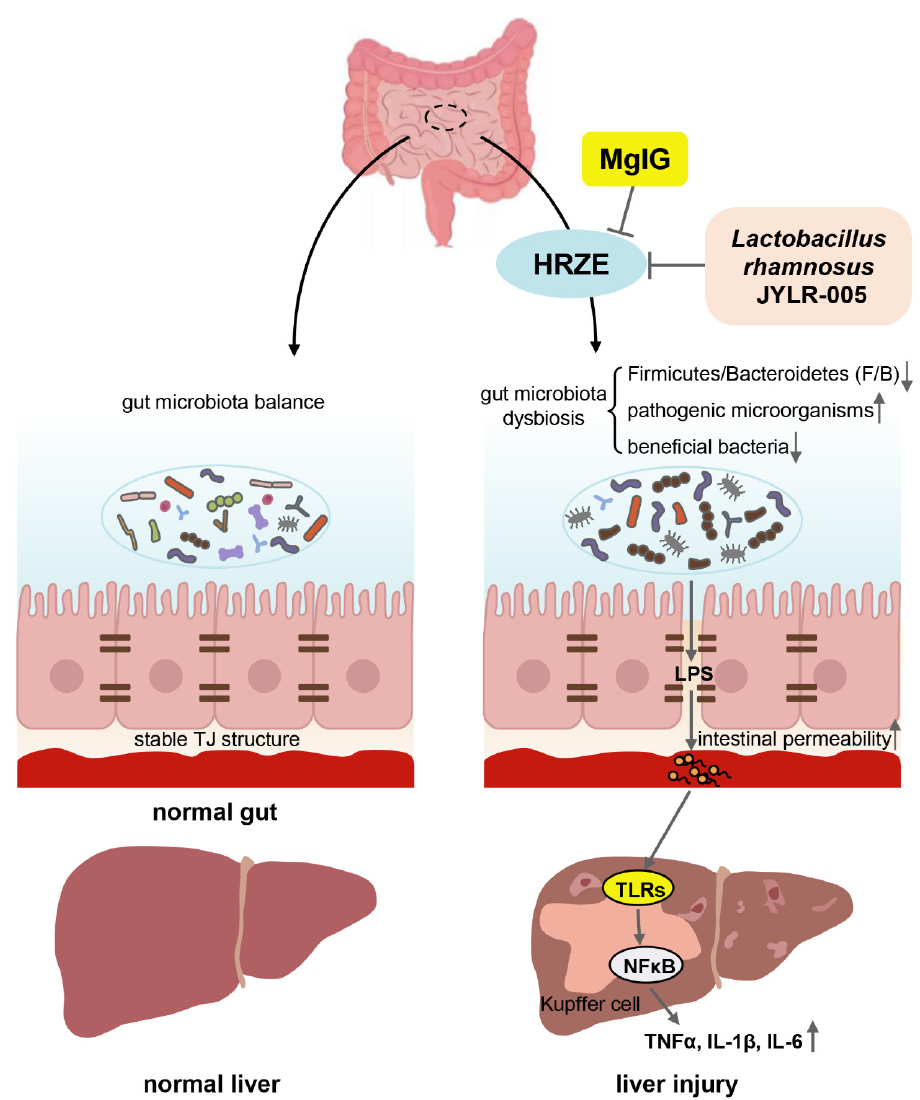
Figure 8. Mechanism of the protective effect of MgIG on HRZE-induced liver injury: MgIG alleviated HRZE-induced disruption in gut microbiota and damage of tight junction structures, then reduced LPS entry into the blood, inhibited the liver TLRs/NF- κ B pathway and subsequent inflammatory response. Supplementation of Lactobacillus rhamnosus JYLR-005 alleviated HRZE-induced liver injury to a certain extent.